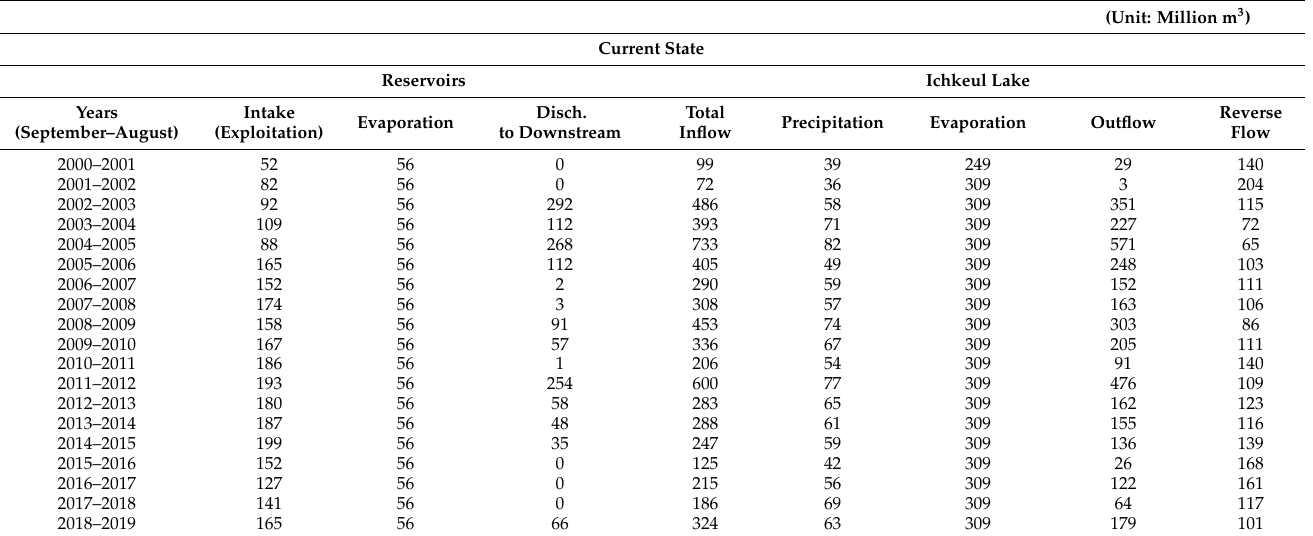
Table 3. Annual water budgets from September 2000 to August 2019 under the current